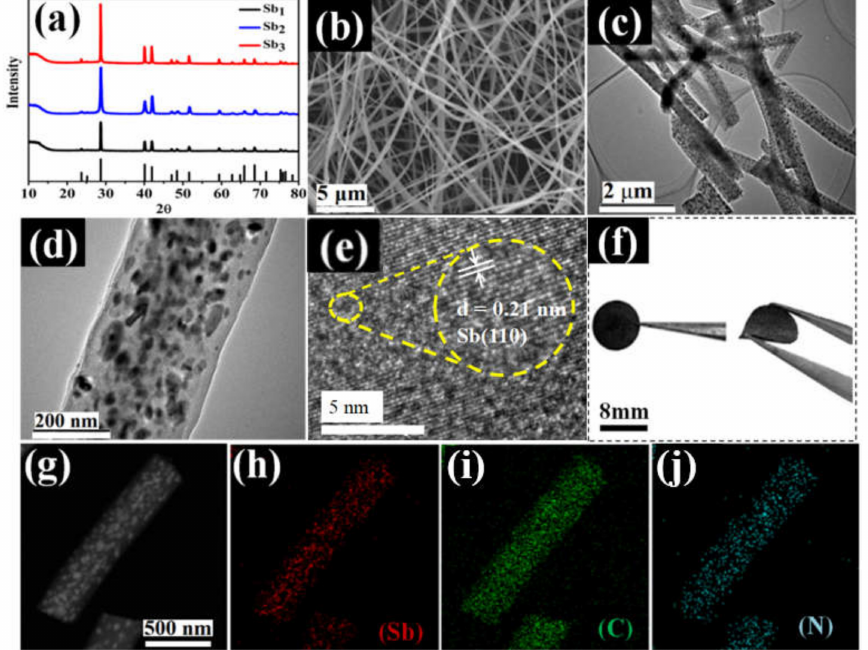
Figure 2. ( a ) XRD patterns of Sb 1 , Sb 2 , Sb 3 , ( b ) SEM images of Sb 3 , ( c , d ) TEM image of Sb 3 , ( e ) HRTEM image of Sb 3 , ( f ) optical images of flexible Sb@NCFs, and ( g ) HAADF-STEM image of Sb 3 and EDS mappings of ( h ) Sb, ( i ) C and ( j )